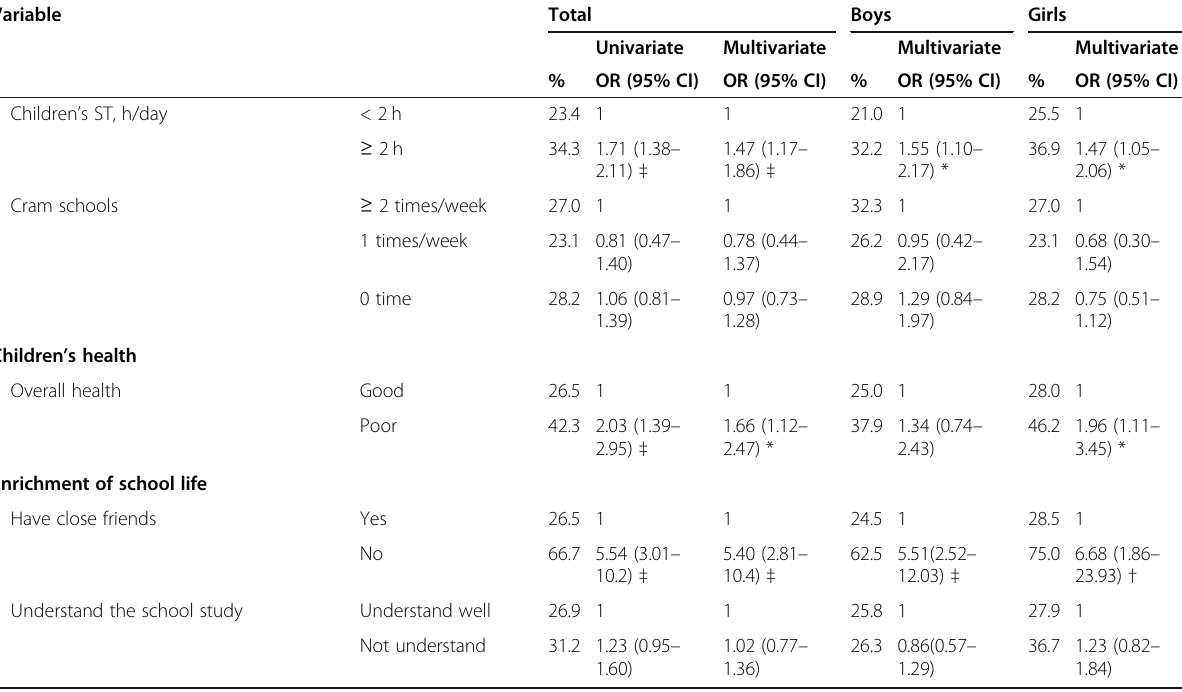
Table 3 Logistic regression analysis results for “ Lack of physical activity ” ( n = 1721) (Continued)